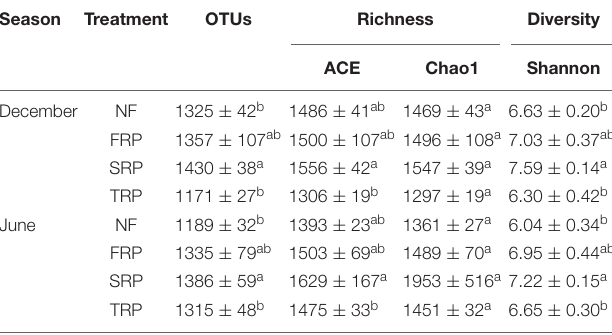
Similarly, the RDA showed that the first and second axes explained 25.61 and 18.59%, respectively, of the total variance in soil bacterial communities across two sampling months ( Figure 4B ). Among all the soil properties, soil ammonium, AP, and DOCN accounted for the greatest proportions of the variation in the bacterial communities ( Figure 4B ). There were significant positive relationships between soil moisture and Shannon index, as well as between soil DON and bacterial diversity indices (Chao1 and ACE) ( Supplementary Table S4 ).